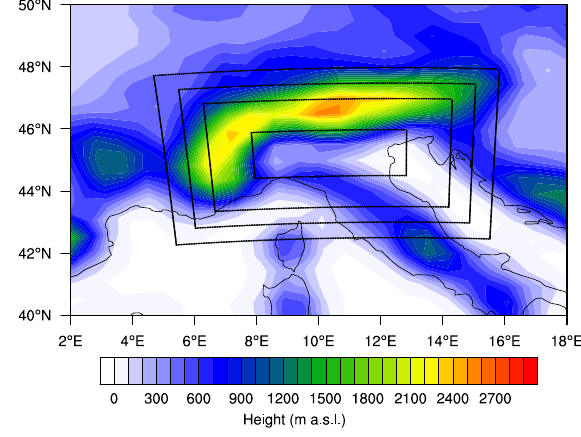
Fig. 1. Model orography in the area of interest. Boxes surround the forcing area (inner box) and the 3 progressively larger frames on which the analysis was performed.